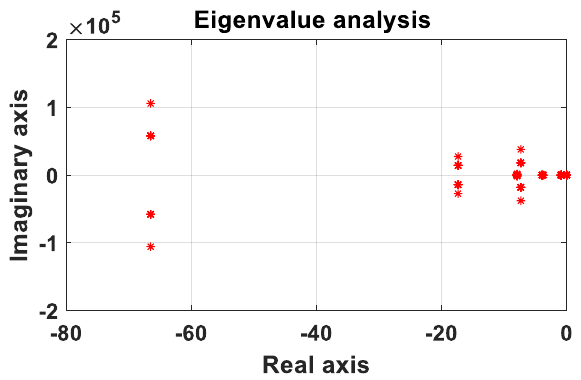
Figure 9. Impact of the variation in inductance on the DC grid.